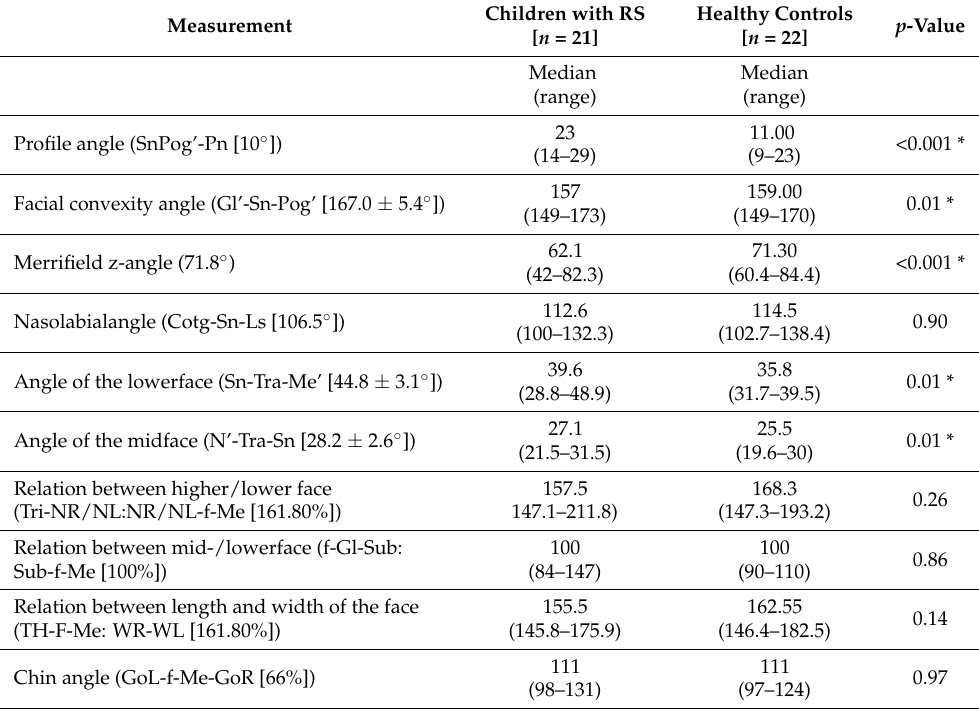
Table 3. Values of facial soft tissue analysis of children with Robin sequence (RS) compared to the control group